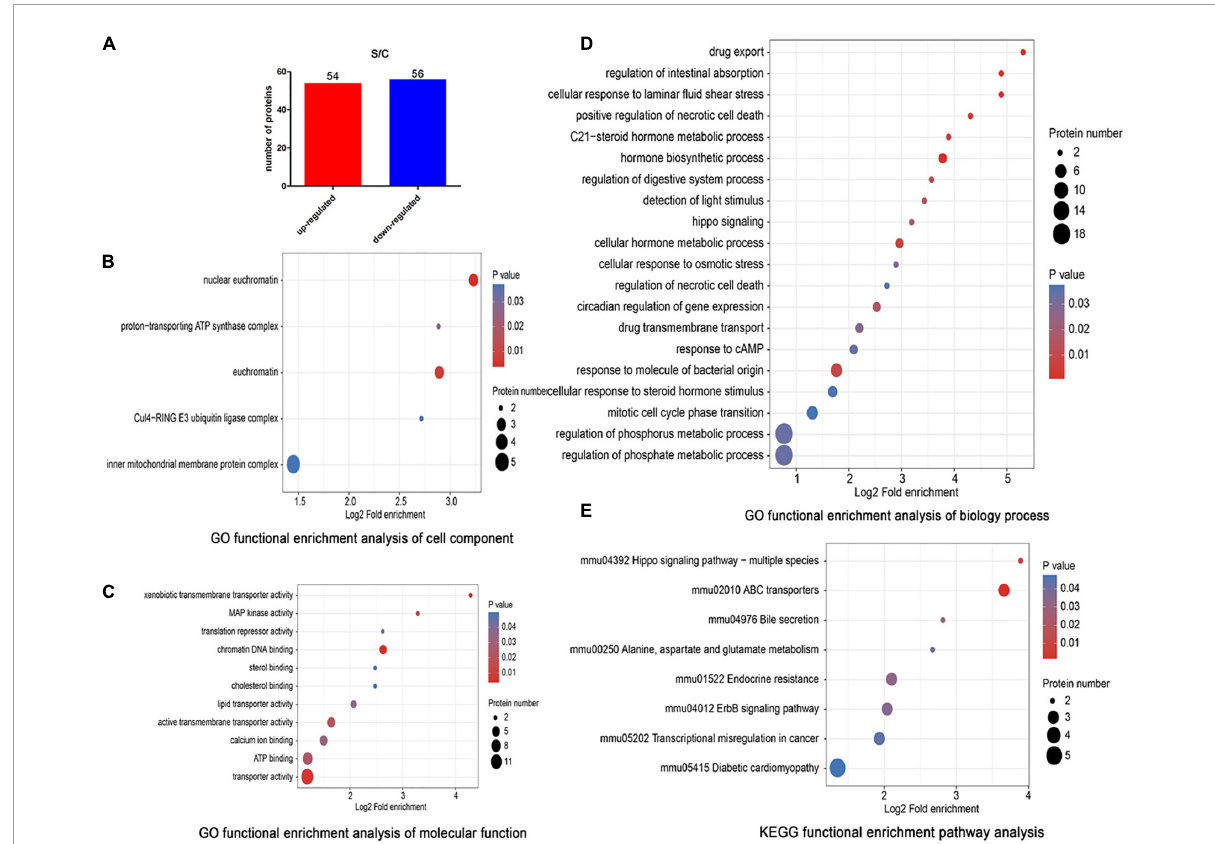
FIGURE8 Proteomic analysis of the S/C comparable group. (A) In the S/C comparable group, we identified 110 DEPs, including 54 up-regulated and 56 down-regulated genes (using a 1.5-fold cutoff, P < 0.05). (B) The top 20 enriched GO terms of DEPs (fold change > 1.5) based on cellular component. (C) The top 20 enriched GO terms of DEPs (fold change > 1.5) based on molecular functions. (D) GO enrichment analysis of DEPs based on biological process (fold change > 1.5). (E) KEGG enrichment analysis following S/C group (fold change > 1.5). C, NSC34-hSOD1G93A cells. S, NSC34-hSOD1G93A cells treated with 100 nM